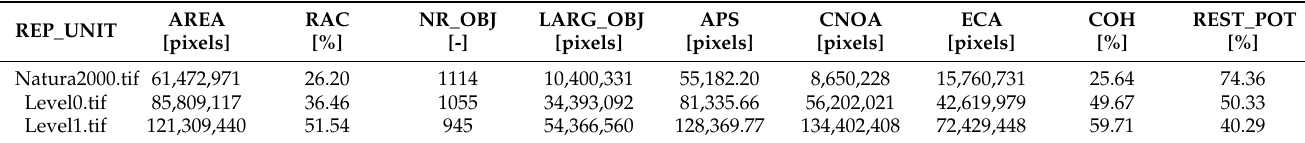
Table 1. Network status summary for the three scenarios.